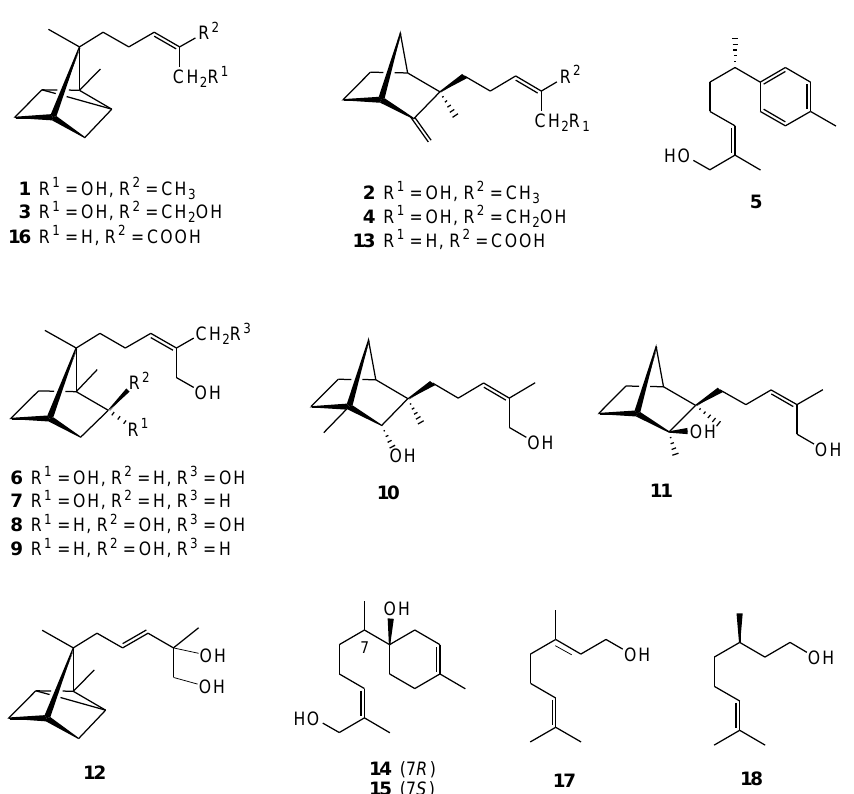
Figure 1. Structures of the tested compounds isolated from S. album of Indian Origin.